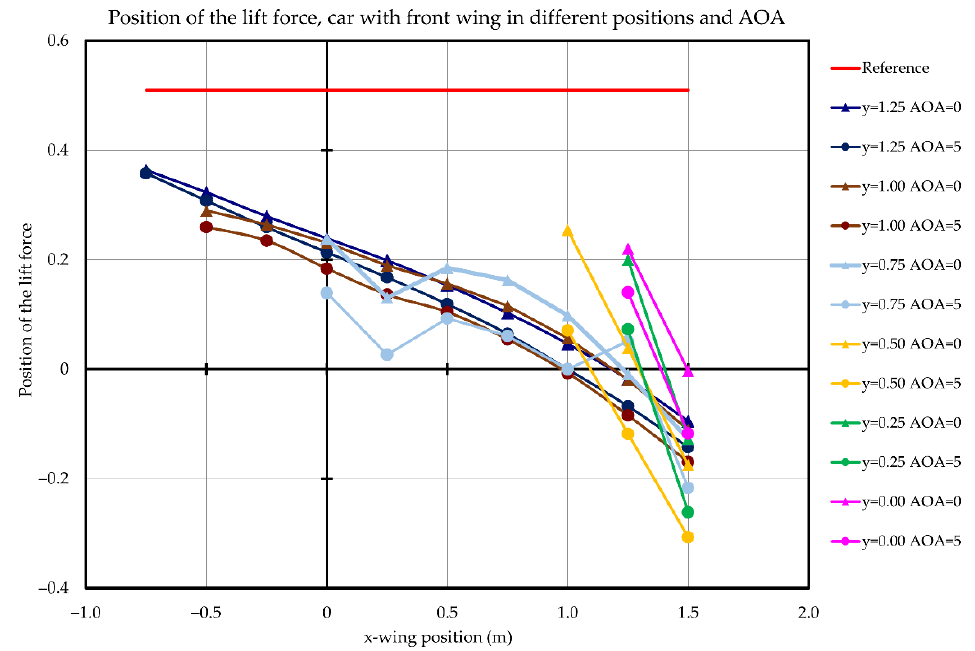
Figure 27. Position of the resultant aerodynamic lift force relative to the front (value 0) and rear (value 1) axle positions. Negative values indicate that the position is in front of the front